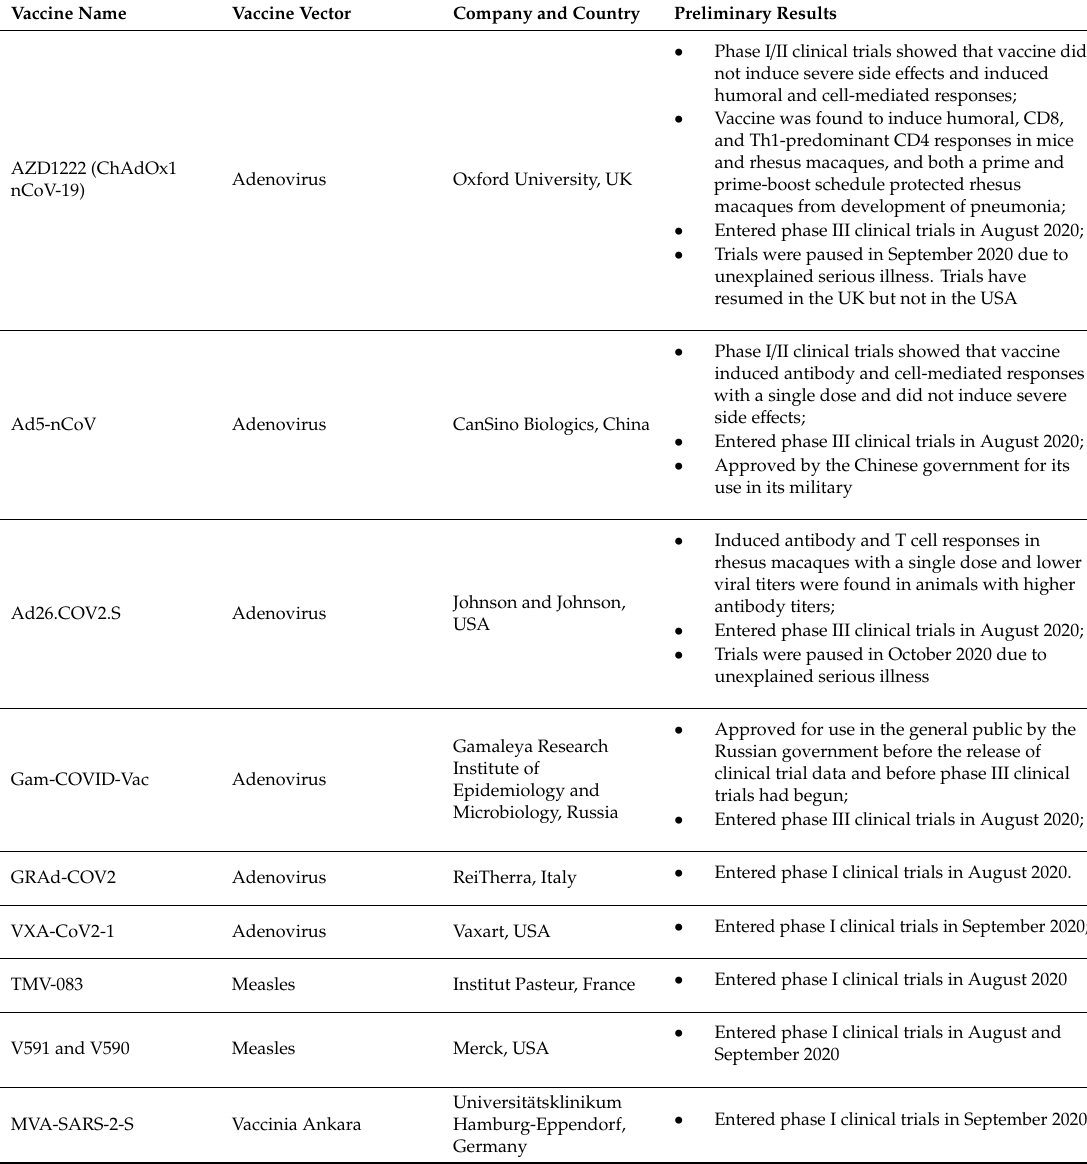
Table 4. Viral vectored vaccines currently in development for SARS-CoV-2